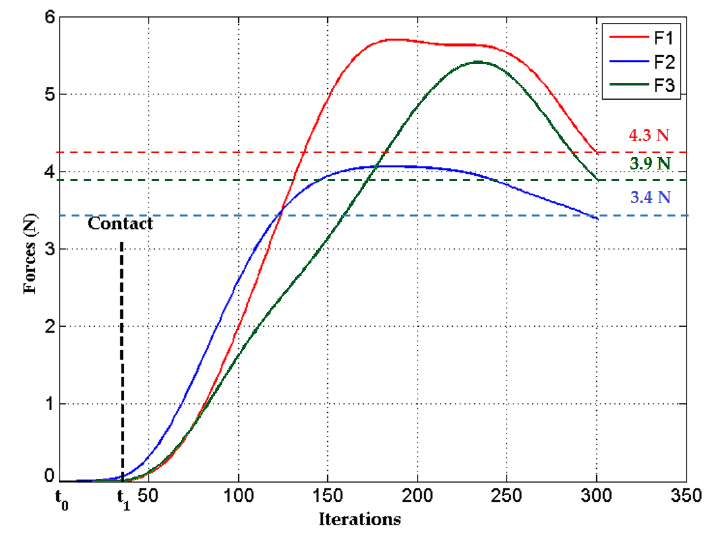
Figure 13. Grasping forces applied by the three fingers of the Barrett hand (F1, F2 and F3) in